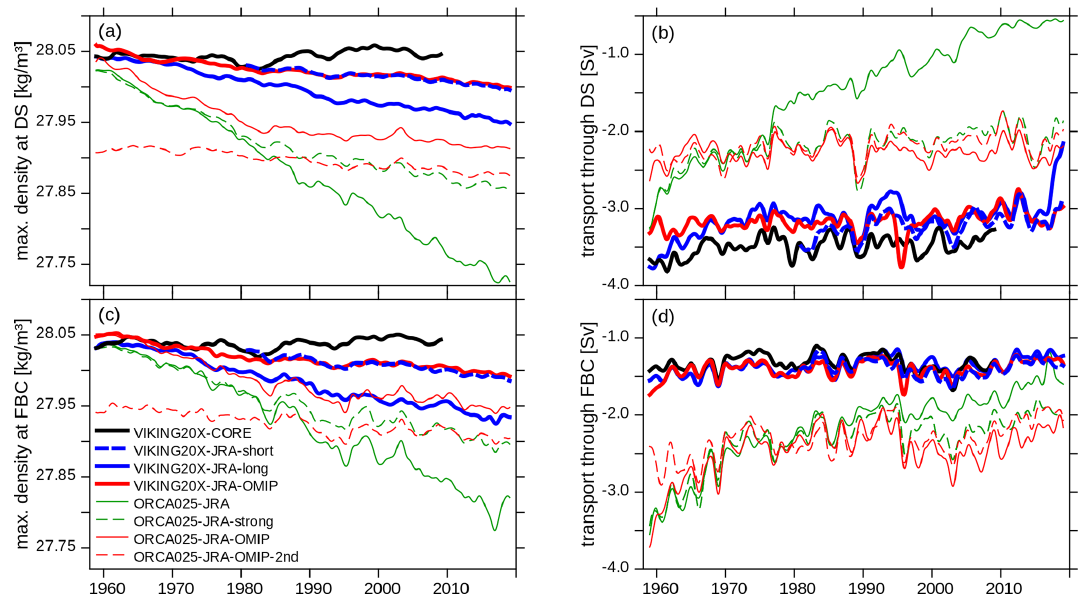
Figure 8. Evolution of maximum overflow density and the overflow transport in the (a, b) Denmark Strait and the (c, d) Faroe Bank Channel. Overflow transport estimates are based on southward transport of waters with density larger than 27.70kgm − 3 below